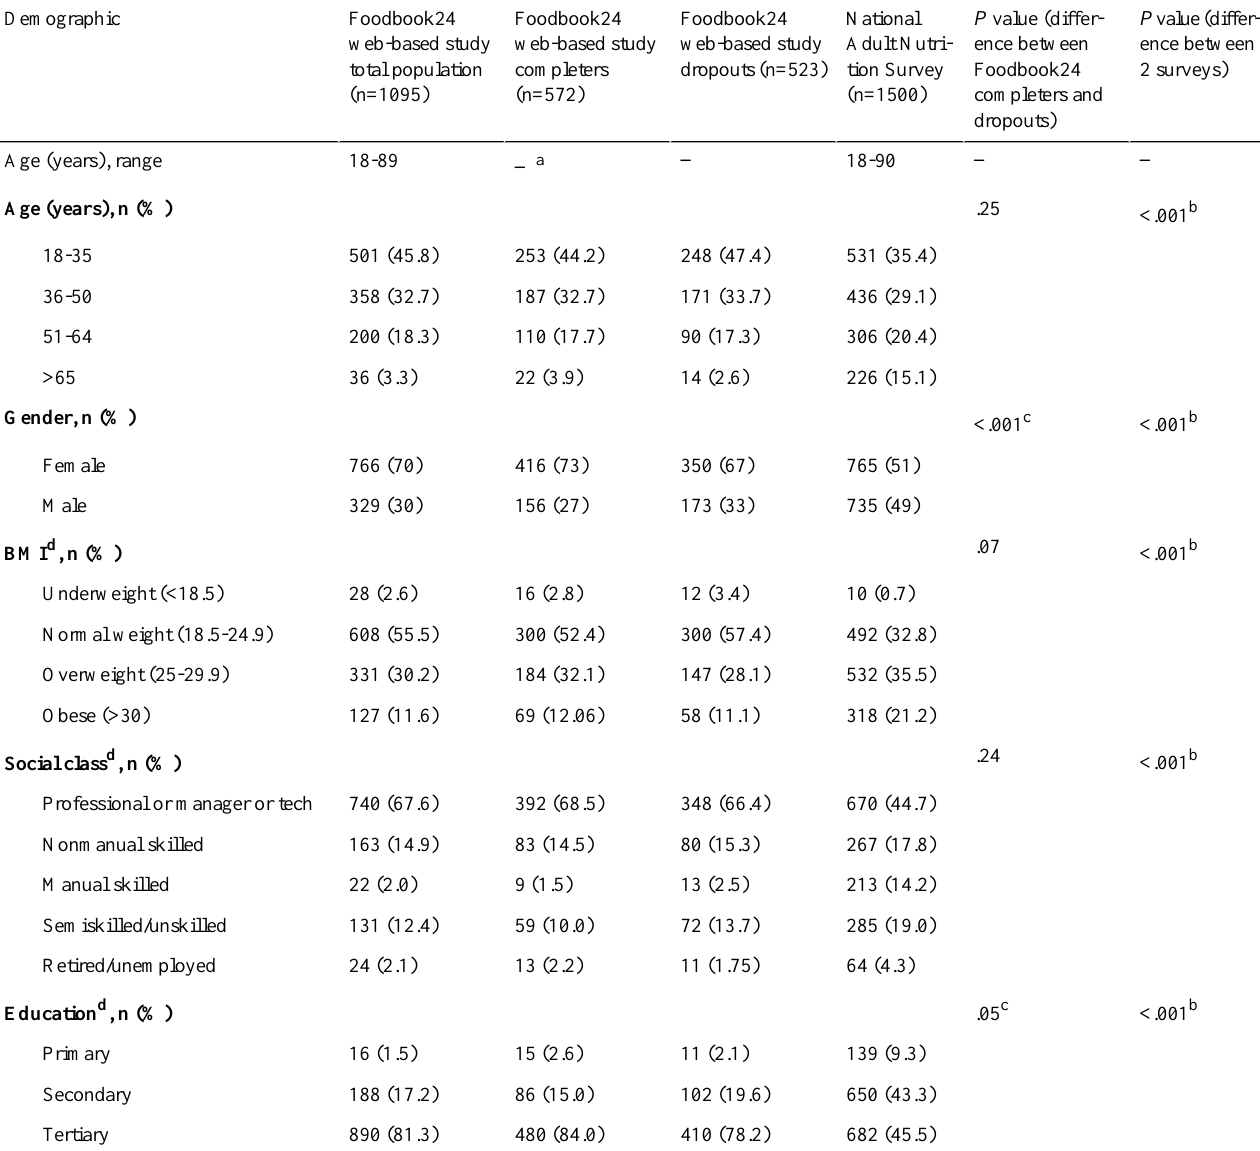
Table 1. Demographic characteristics of participants involved in the Foodbook24 web-based study (2016) and the National Adult Nutrition Survey